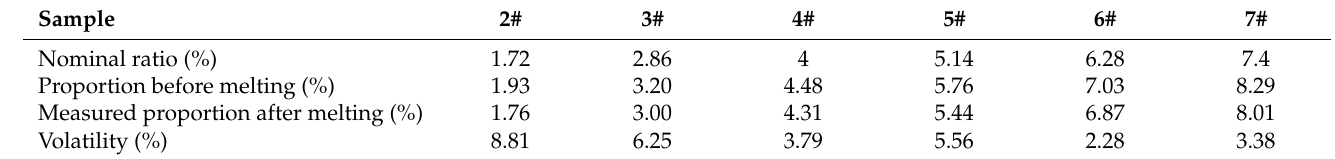
Table 1. The quality contents of B 2 O 3 in all samples (wt%). All data were only calculated for